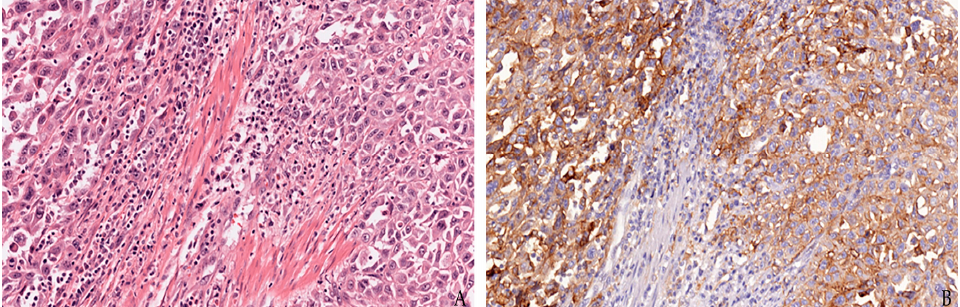
Figure 3. Representative image for PD-L1 immunostaining in urothelial carcinoma: hematoxylin and eosin ( A ) and PD-L1 22C3 clone by Dako ( B ).